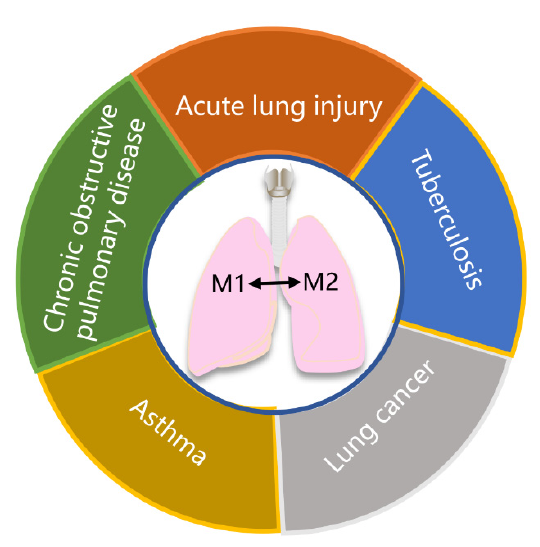
Figure 4. Schematic diagram of important lung diseases involving macrophage polarization. Macrophage polarization plays a crucial role in the pathophysiology of various lung diseases, including acute lung injury, chronic obstructive pulmonary disease, asthma, tuberculosis, and lung cancer.